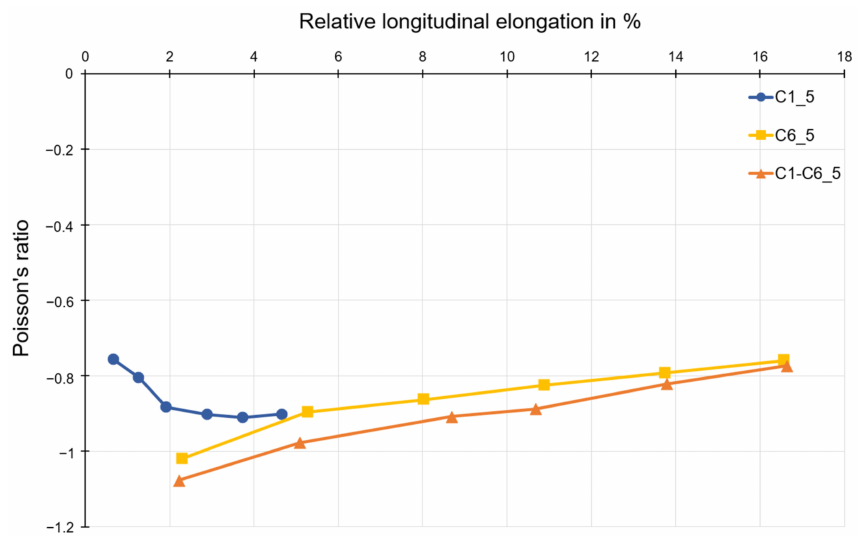
Figure 16. Comparison of Poisson’s ratio as a function of longitudinal elongation for dual printed specimens and specimens made of only one